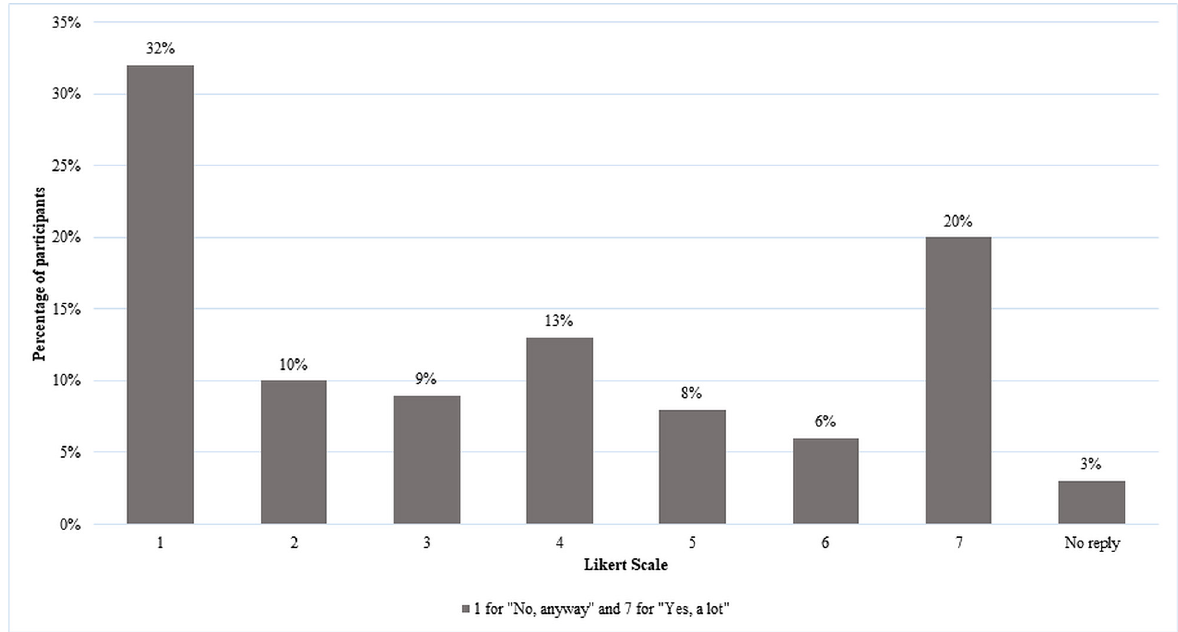
Figure 1. Participants’ evaluation of the feeling of pride related to the BMR, using the Likert